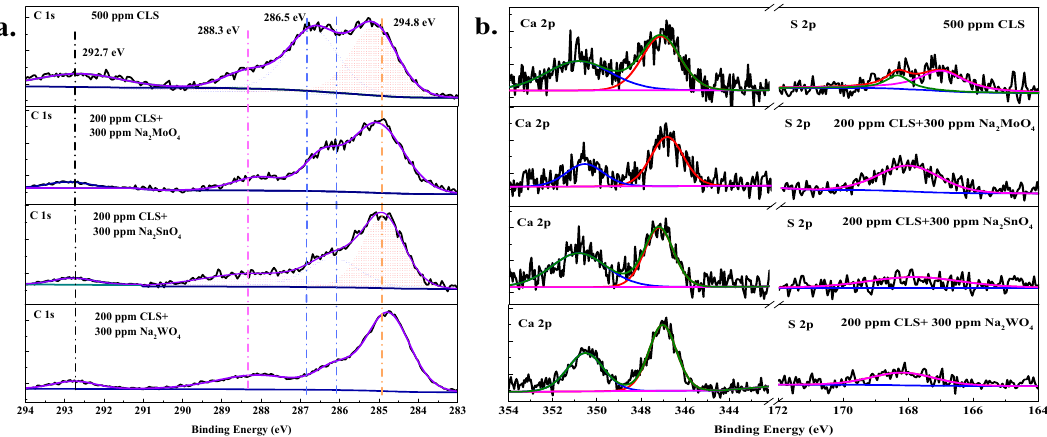
Figure 11. High-resolution XPS spectrum of Q235 carbon steel in the test solution with CLS and inorganic inhibitors: ( a ) C 1s; ( b ) Ca 2p and S 2p. inorganic inhibitors: ( a ) C 1s; ( b ) Ca 2p and S